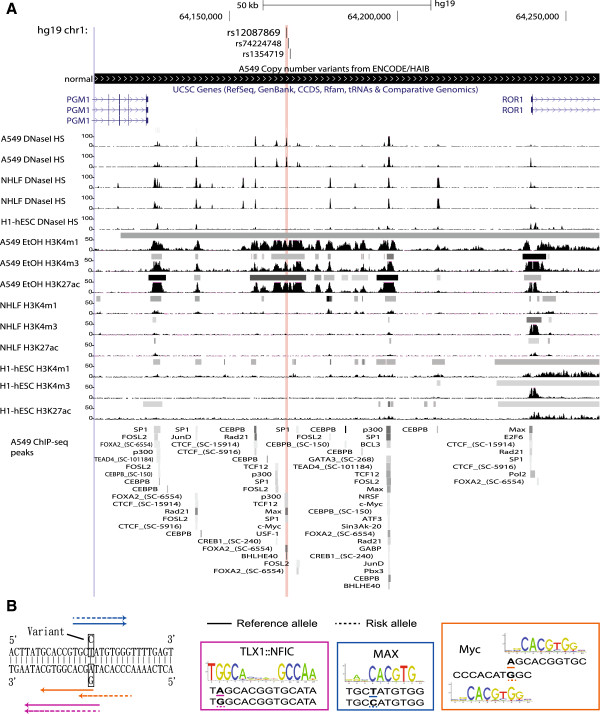
Annotation features proximal to the rs12087869 SNP location from the Lung.Meta case study. Part (A) depicts annotation related to genetics, epigenetics, and TAF ChIP-seq peaks in proximity to the rs12087869 SNP in A549 lung cancer, NHLF normal and H1 embryonic stem cell lines using the UCSC Genome Browser. The red vertical line highlights the location of the SNP. From the top of the figure, the genetic information includes the locations of the SNP and proximal genes, and copy number status in A549 cells. The chromatin information shows the DNase I hypersensitive sites, occupancy sites of active histone modification marks (H3K4me1, H3K4me3, H3K27ac) in the cell lines. The ChIP-seq section shows the TAF-associated regions in A549 cells where data is available. Peaks of chromatin information and ChIP-seq sections were reported by the ENCODE project with the gray scale color reflecting the magnitude of open chromatin and binding. (B) The figure illustrates both strands of the reference sequence within 15 base pairs of rs12087869, and locations of predicted TF binding sites for the reference and risk alleles in solid and dotted lines, respectively. The motif logos for the binding properties of TLX1::NFIC, MAX and Myc are also depicted at rs12087869 risk allele all with increasing binding affinity. The variant within each binding sequence below each logo is underlined, and the predicted Myc binding locations for the reference and risk alleles are different, whereas those of TLX1:NFIC and MAX were the same.